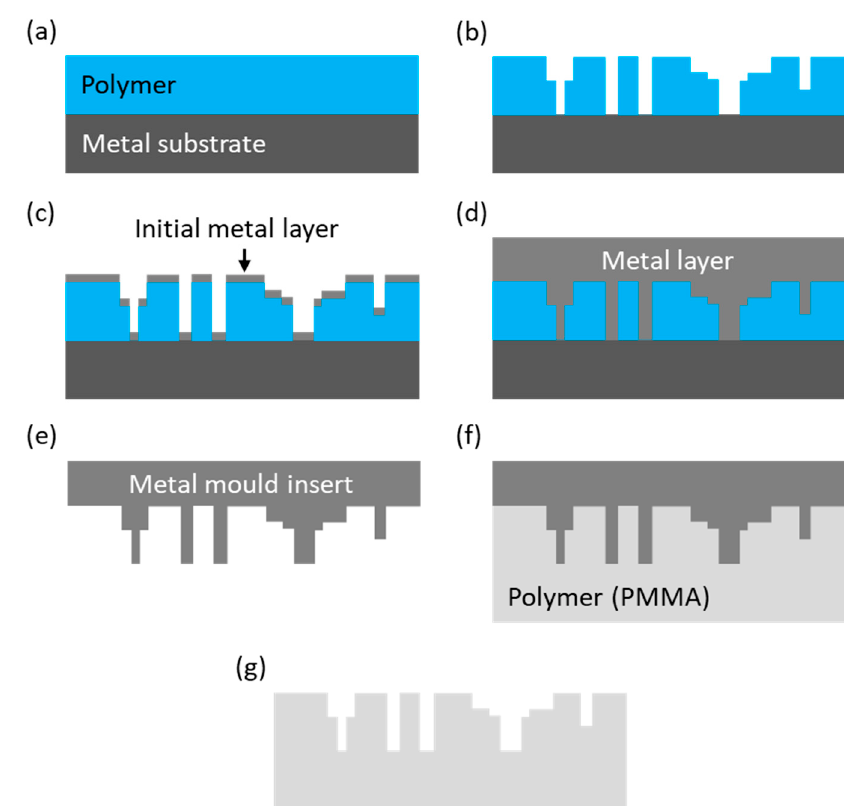
Figure 3. Scheme of the process sequence in LIGA: ( a ) spin coating and baking, ( b ) microlithography or direct laser writing, ( c ) and ( d ) electroplating, ( e ) machining, separation and dissolution of the polymer, ( f ) injection moulding or embossing, and ( g ) demoulding.